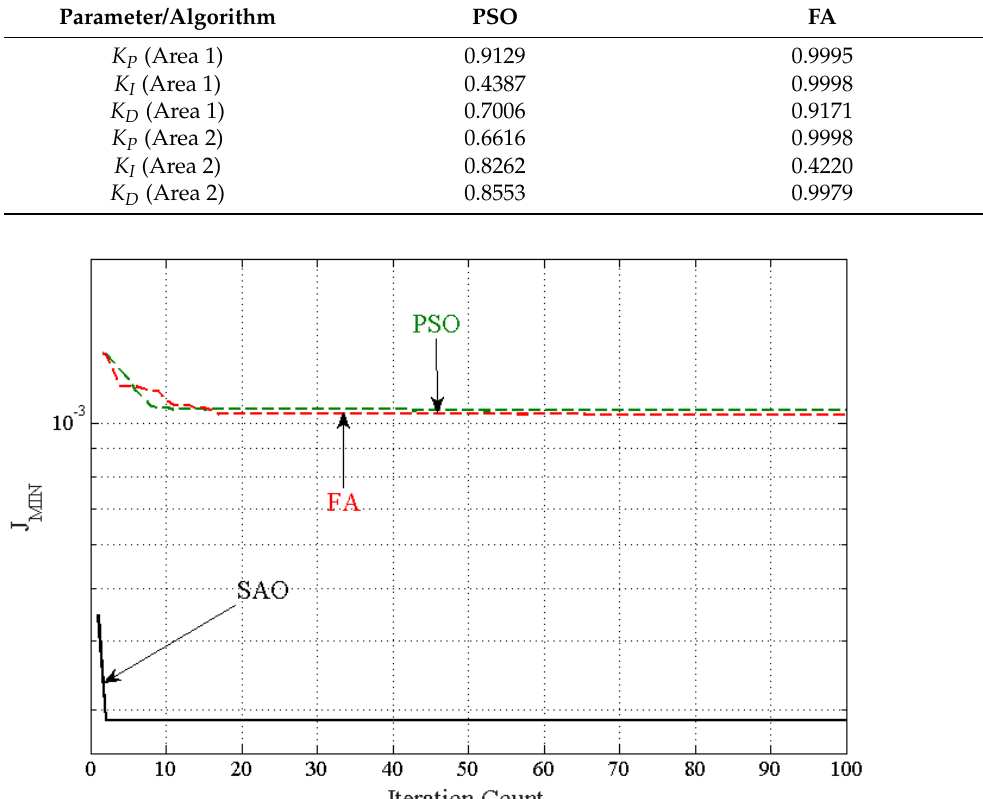
17 of 26 Figure 12. System responses for randomized nature disturbance. ( a ) ∆ f 1 ; ( b ) ∆ f 2 ; and ( c ) ∆ P tie . 5.3. Evaluation of Performances of SAO, FA, and PSO Techniques In all the above studies, the SAO algorithm is used to tune all the parameters of the controllers. Herein, an a tt empt is made to compare the SAO algorithm with the recently used fi re fl y algorithm and particle swarm optimization methods. From the above studies, the superior PID controller is taken for this purpose, and its parameters are individually